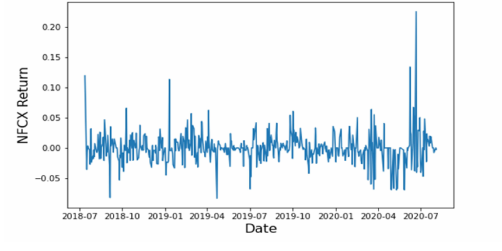
Fig. 2 Time Series Plot of NFCX Return